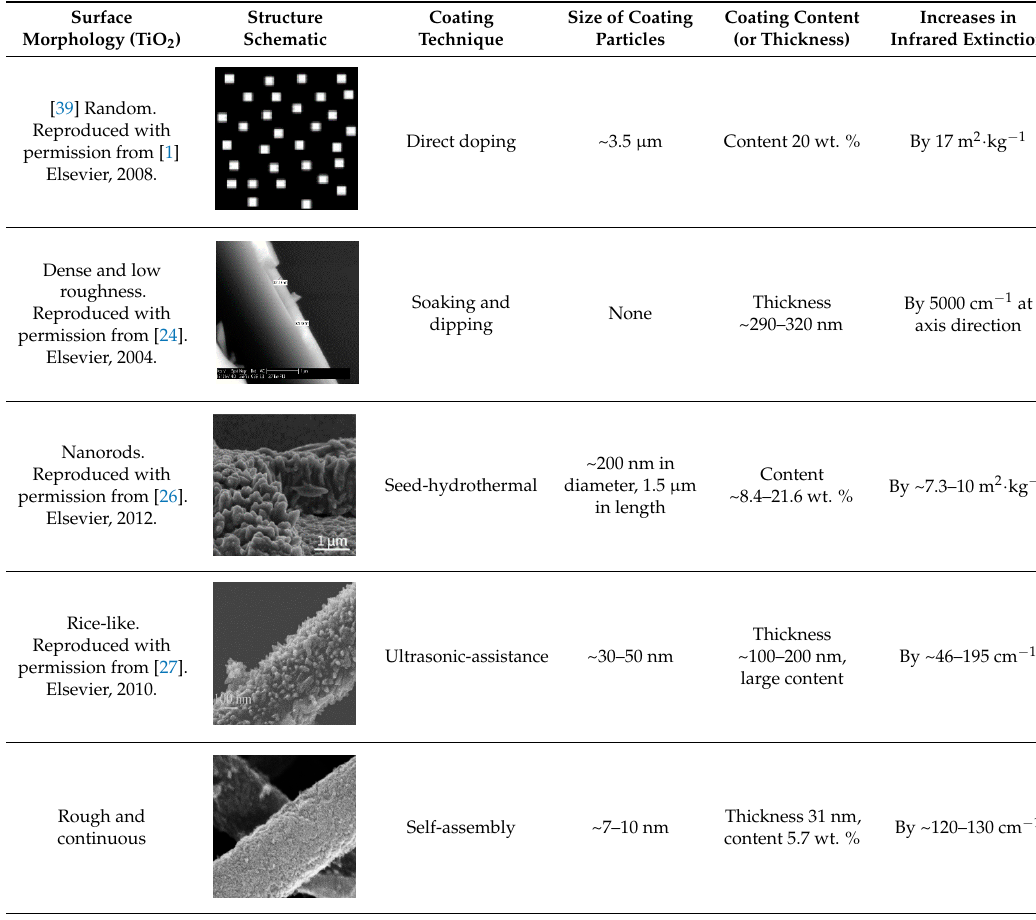
Table 3. Different surface morphologies for increases in infrared extinction.